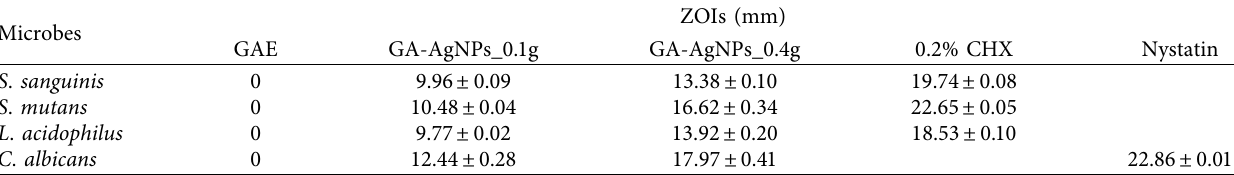
Table 3: MICs values for the GA-AgNPs.